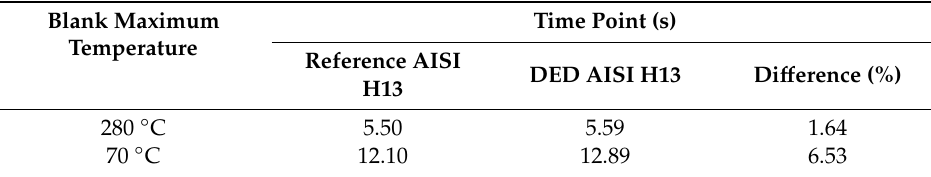
Figure 6. Blank maximum temperature evolution during the hot stamping process. Table 8. Results of the simulated case study.